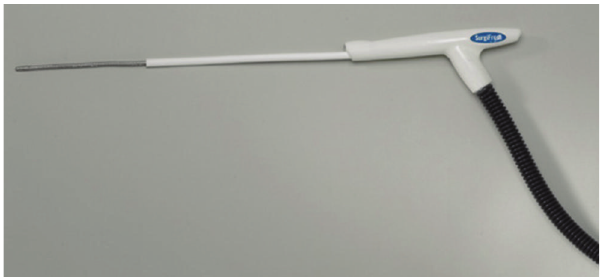
Figure 4: Argon-based ATS CryoMaze TM surgical ablation system.